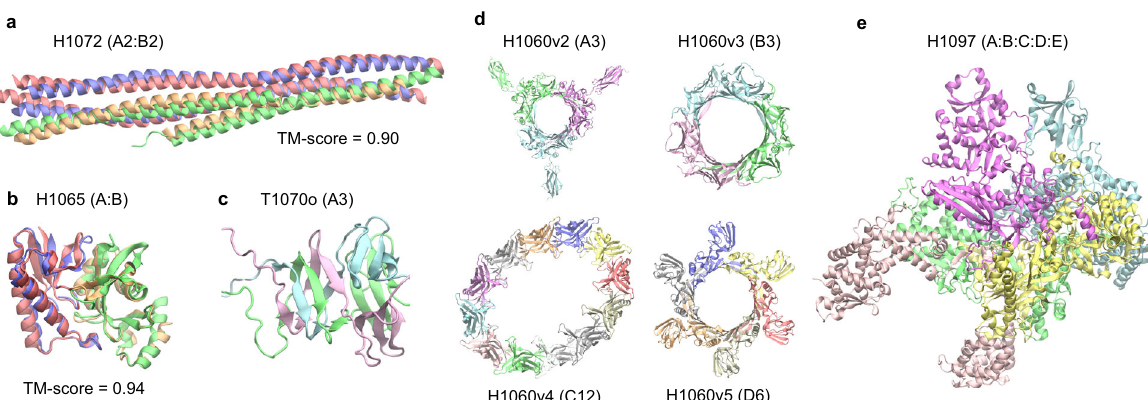
Fig. 2 Top complex models generated by AF2Complex for selected CASP14 assembly targets. Each target is labeled with its target name, e.g., H1072, followed by its stoichiometry in parentheses, e.g., A 2 :B 2 . For targets with available experimental structure coordinates, the similarity between the model and experimental structure is assessed by the TM-score 39 . For other structures only an image of the predicted model is given. Models are colored red and green, and experimental structures are in blue and gold. a SYCE2-TEX12 delta-Ctip complex. b N4-cytosine methyltransferase. c G3M192 from Escherichia virus CBA120. Only the N-terminal domains, which have an intertwined complex structure, are shown from a model of the full trimer. d Four rings from